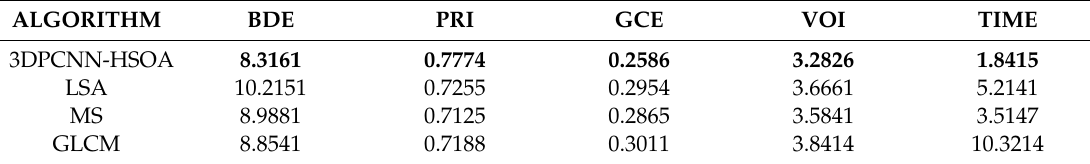
Figure 16. The segmentation results of oil pollution images. ( a ) oil pollution1; ( b ) oil pollution2; ( c ) oil pollution3; and ( d ) oil pollution4. Table 6. The comparison results for the 3DPCNN-HSOA versus other